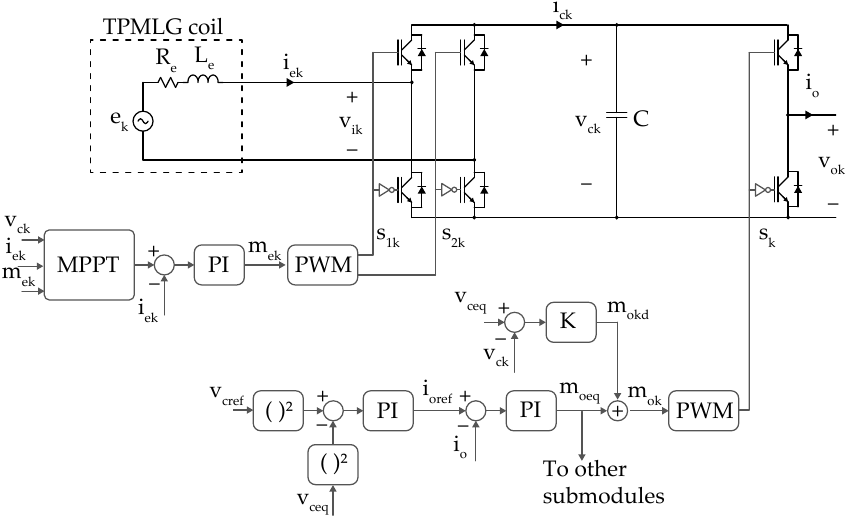
Figure 5. Control scheme of a